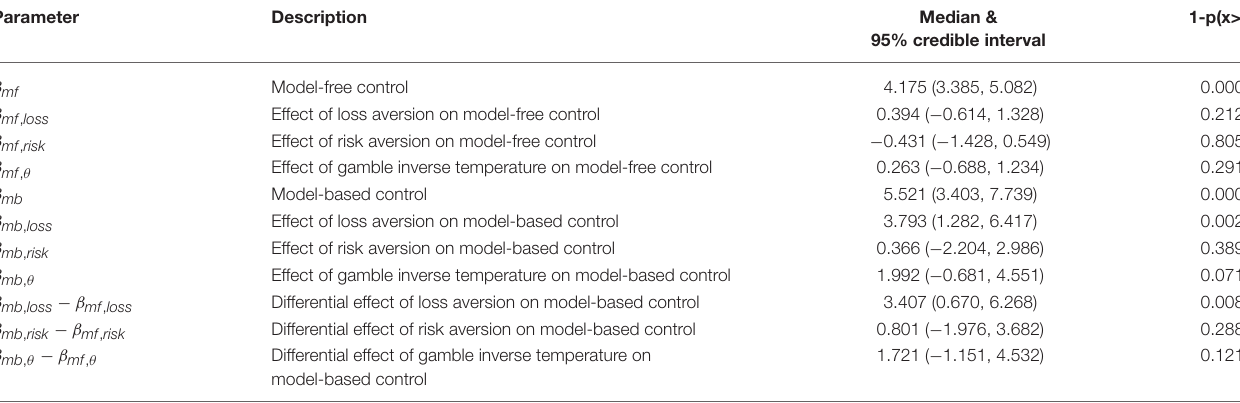
TABLE 4 | Group level estimates of model-based and model-free control in the two-step task, and the effects of the gambling task variables. Parameter